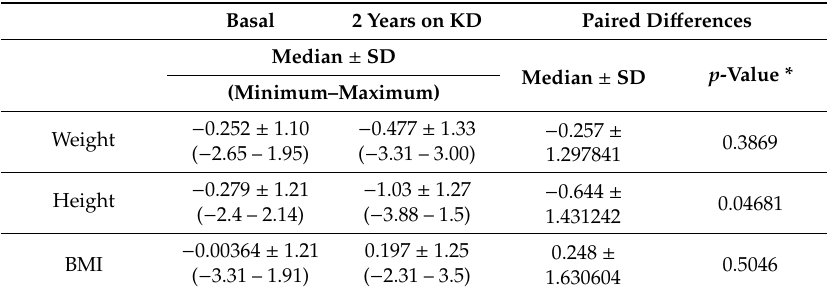
Table 5. Variations of weight, height, and BMI of the z-score.